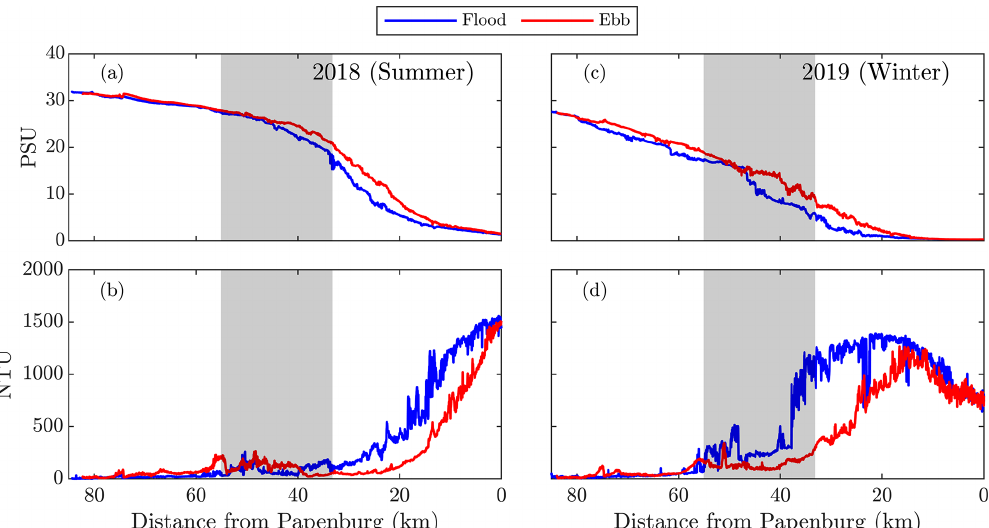
Figure 4. Longitudinal near-surface salinity ( a, c , in PSU) and turbidity ( b, d , in NTU) distribution observed in 2018 (a, c) and 2019 (b, d) , during the flood (blue) and during the ebb (red) cruise. The survey starts at 85km (Borkum) at the beginning of the flood and reaches Papenburg around the transition from flood to ebb after which it sails back for 6h with the ebbing tide. The grey-shaded area denotes the focus area of the EDoM campaign. Observations were made with a near-surface sensor towed by the ship, and therefore no near-bed observations are